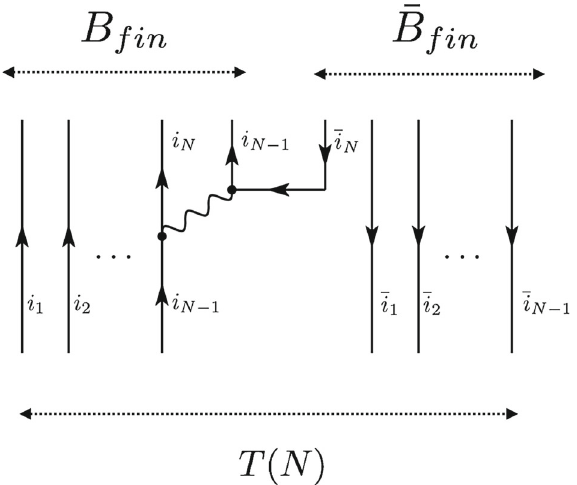
Fig. 3 Feynman diagrams for the tetraquark decays into a pair of baryons, T → B + ¯ B